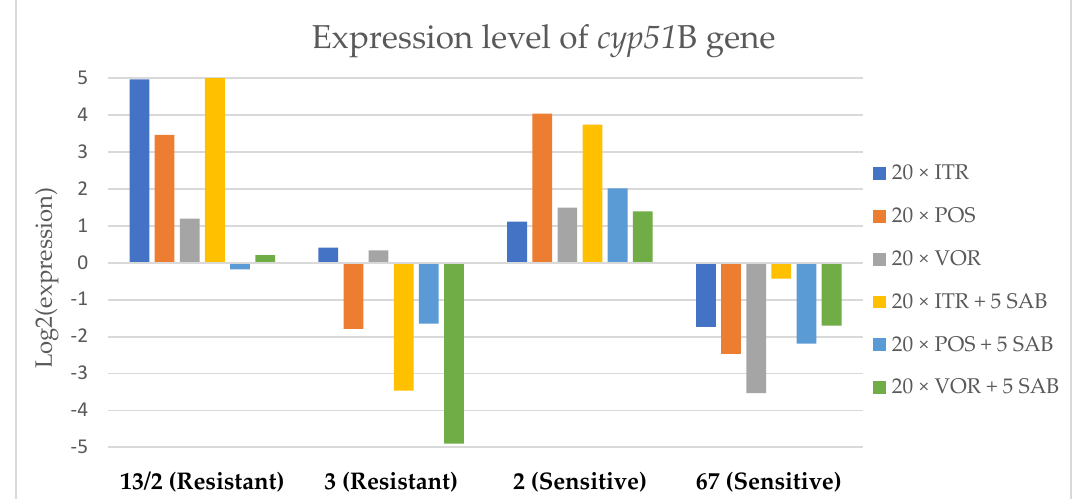
Figure 7. Expression levels of cyp51 A after culturing isolates on SAB with ITR, POS and VOR additions, followed by 5 times culturing on only SAB.